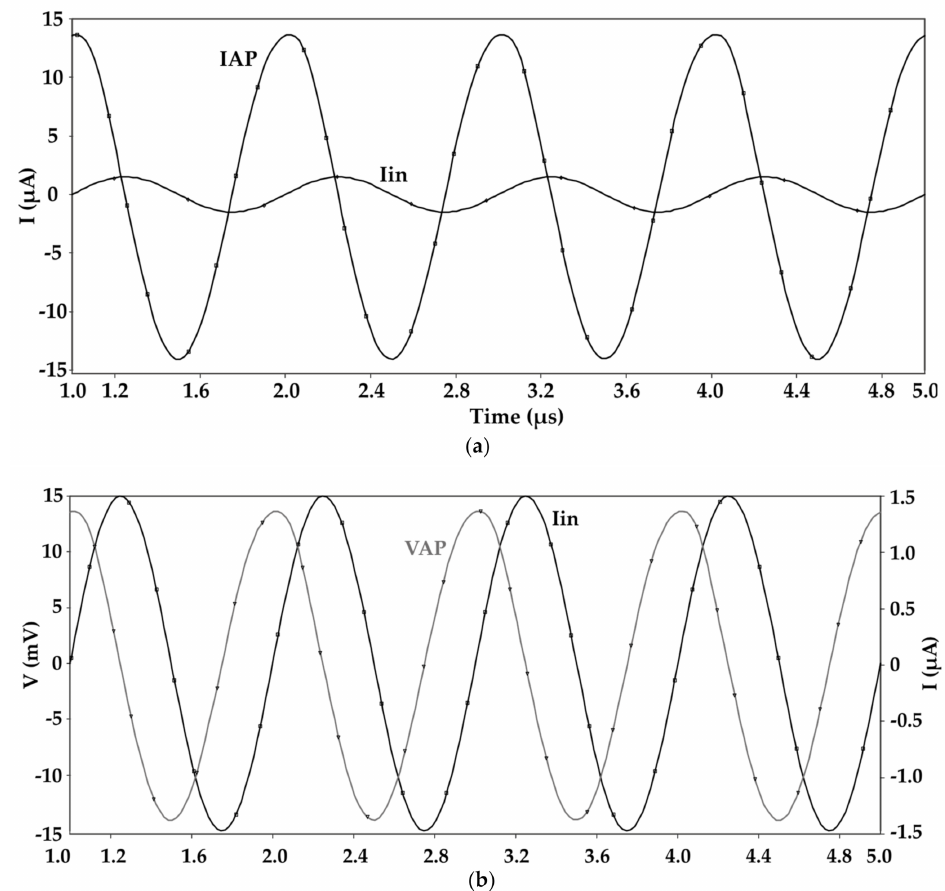
Figure 11. Time domain outputs for ( a ) I AP and ( b ) V AP in the case of I con = 50 µ A and V con = 0